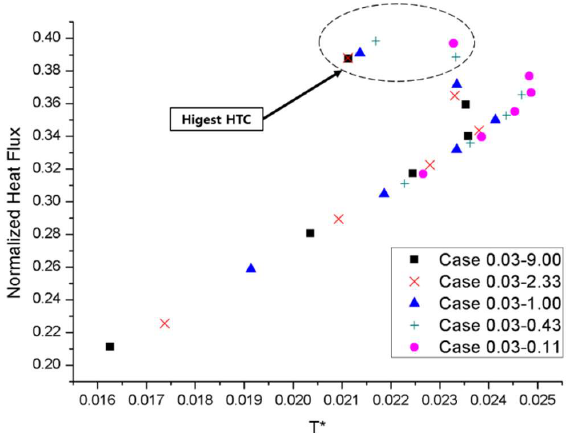
Figure 6. Boiling curves with superheat and heat flux graph according to the pattern ratio in 0.03 L 0 pattern pitch.